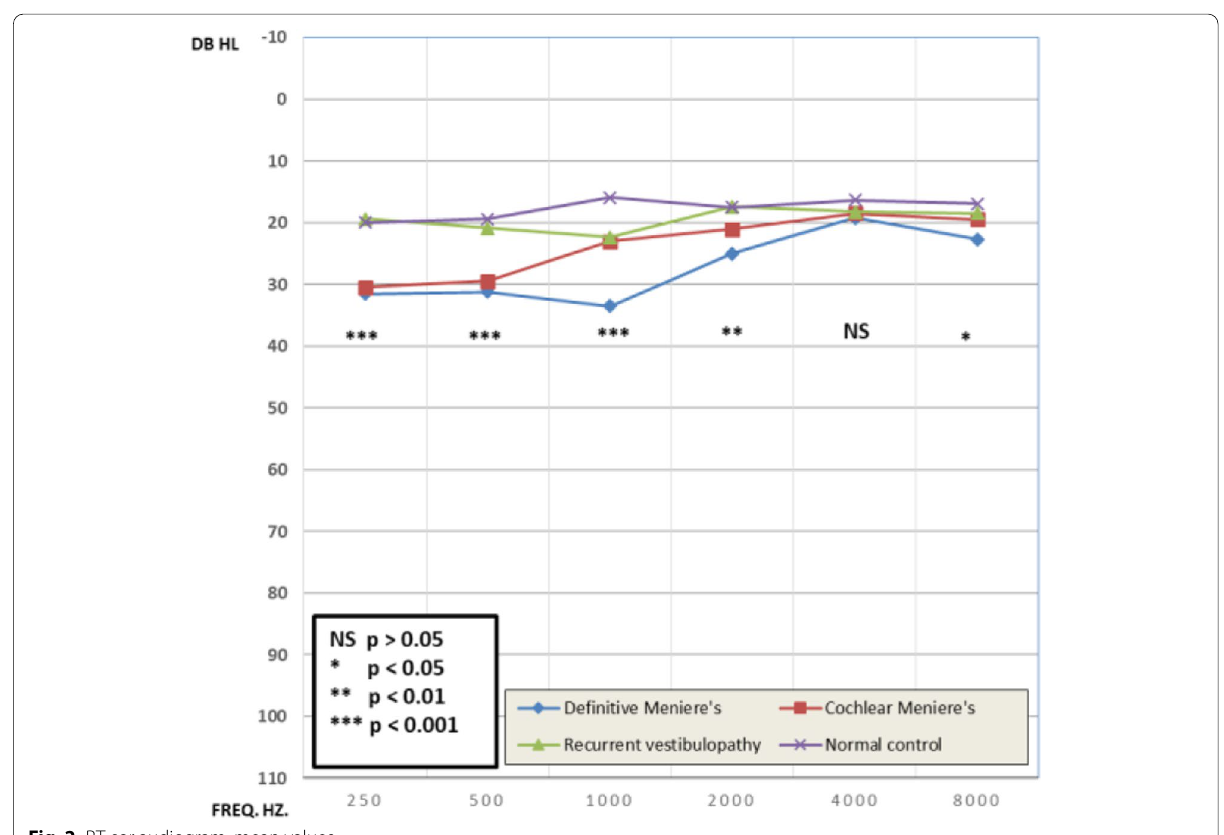
Fig. 2 RT ear audiogram, mean